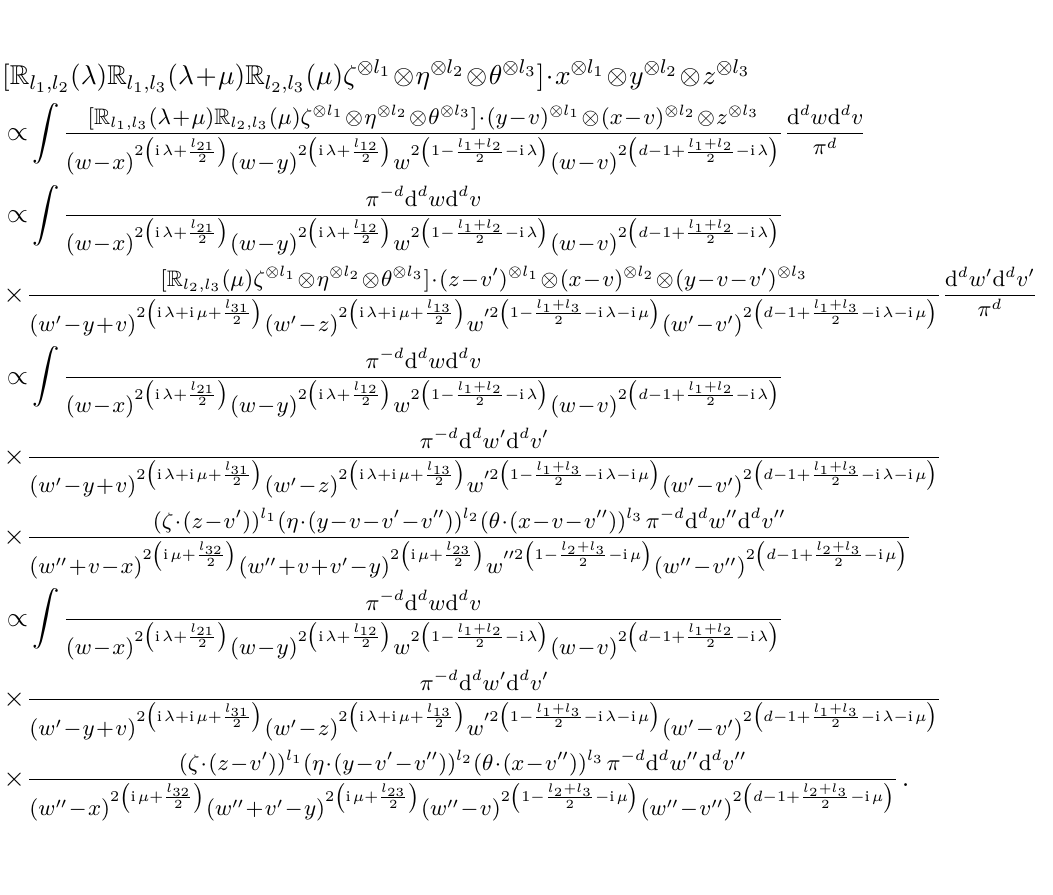
the left-hand side